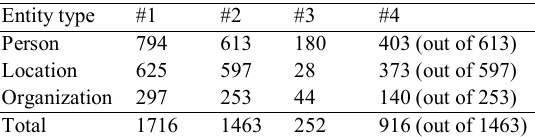
Table 3. Statistics of mentions in the dataset D 1